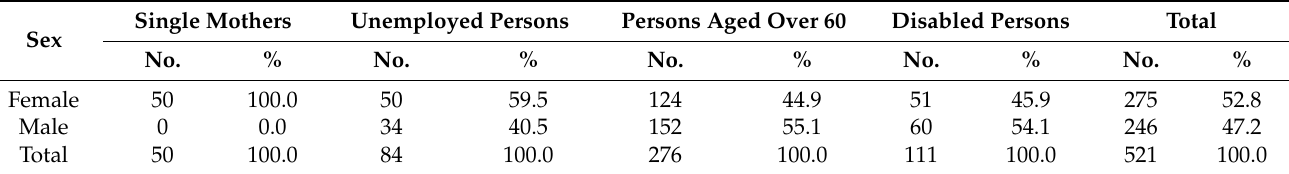
Table 1. Characteristics of the survey population by sex and social status ( n = 521).